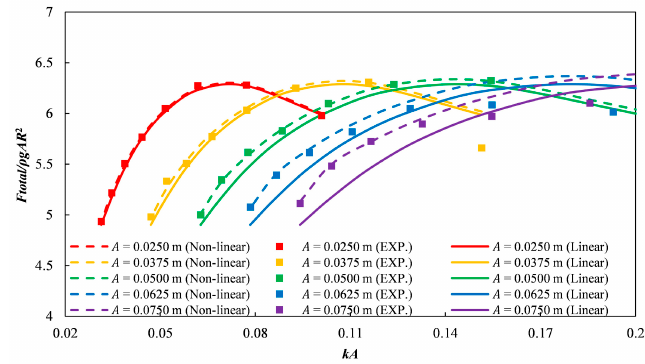
Figure 6. Wave force on monopile for di ff erent wave steepness.